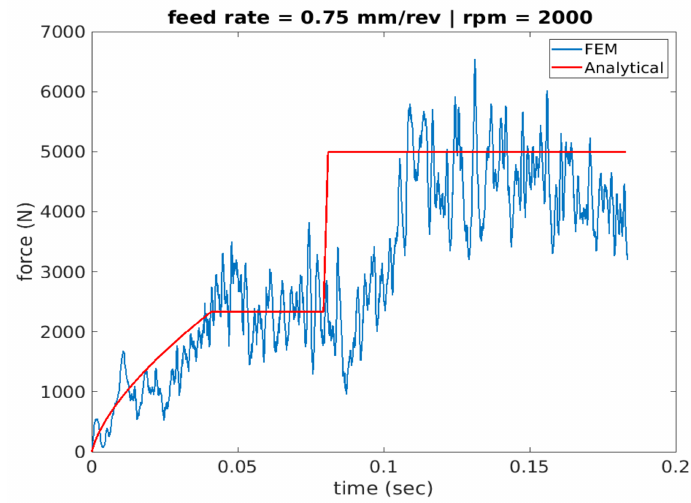
Figure 12. Force profile for scenario 2 of feed rate 0.75 mm/rev and 2000 spindle rpm (analytical vs. FEA).